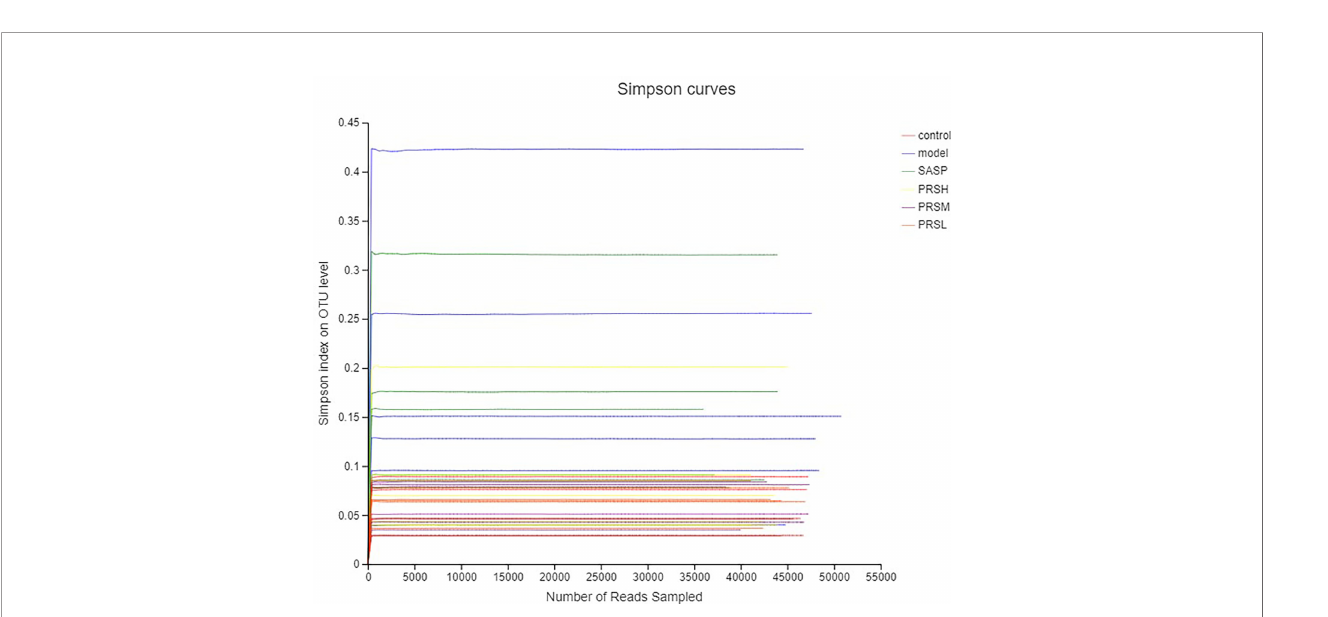
FIGURE 10 | Simpson curves analysis of intestinal microbes in UC